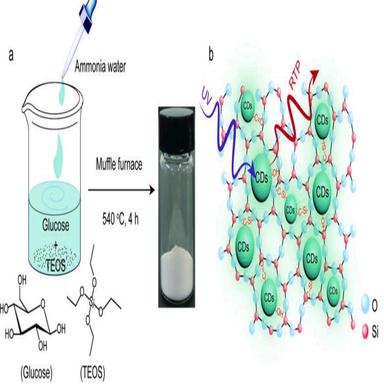
Schematic illustration of (a) the preparation process for the CD@SiO2, (b) the proposed structure of CDs@SiO2.